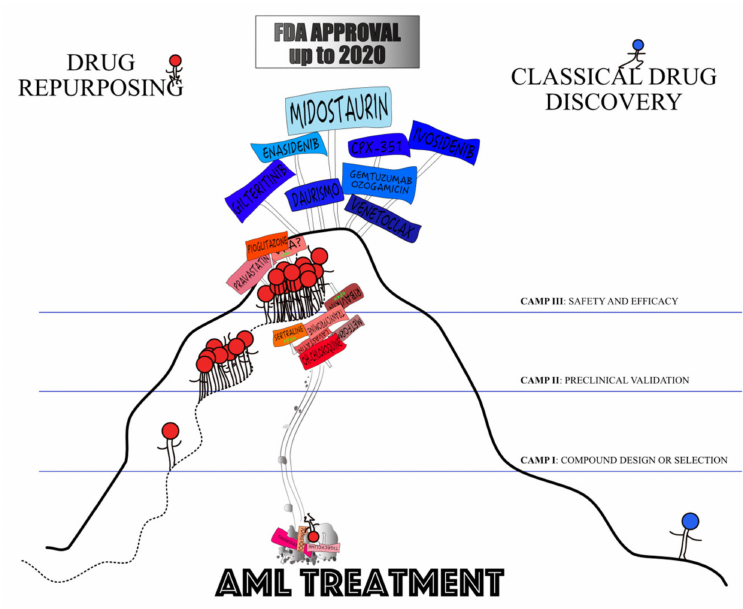
Figure 3. Drug discovery is like climbing a mountain. Repurposing partially follows beaten tracks whilst de novo development carves out new paths for itself. So far only agents developed de novo made it to obtaining the FDA